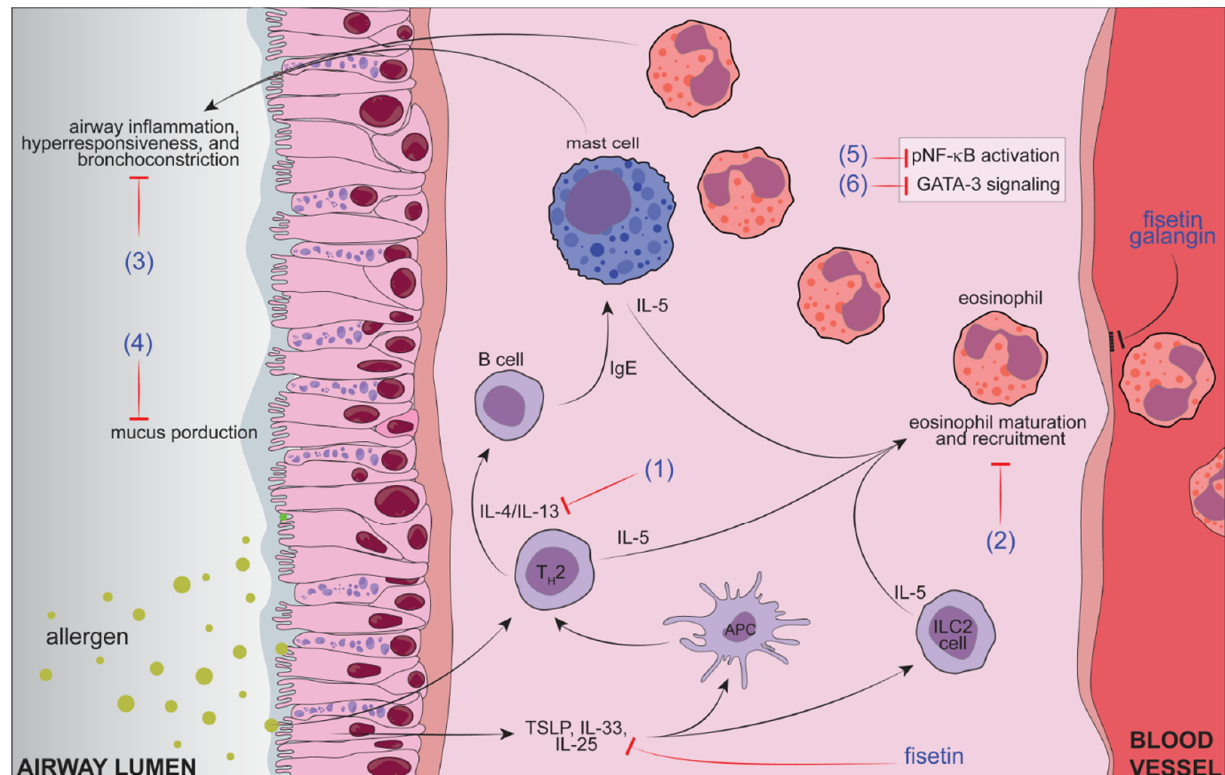
Figure 4. Mechanisms of flavonoids tested in their free forms in allergic asthma models: (1) Naringenin, kaempferol fisetin, licochalcone A, luteolin, apigenin, hesperidin, sakuranetin, naringenin chalcone, genistein, isoquercitrin, and sulfuretin inhibit Th2 cytokines; (2) Naringenin, kaempferol fisetin, licochalcone A, rutin, apigenin, hesperidin, sakuranetin, naringenin chalcone, genistein, isoquercitrin, galangin, and sulfuretin inhibit leukocyte recruitment, especially eosinophils; (3) Kaempferol, fisetin, licochalcone A, luteolin, rutin, apigenin, hesperidin, sakuranetin, naringenin chalcone, and sulfuretin inhibit airway hyperresponsiveness; (4) Kaempferol, fisetin, luteolin, and galangin inhibit mucus production; (5) Fisetin, sakuranetin, and sulfuretin inhibit NFkB (p65) activation; (6) Fisetin, apigenin, hesperidin, and genistein inhibit GATA-3 signaling. Fisetin inhibits TSLP. Fisetin and galangin inhibit adhesion molecules in endothelial cells. Figure was designed in Adobe Illustrator 2023 (Adobe©, San Jose, CA, EUA).